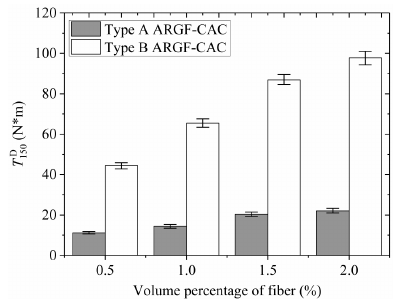
Figure 16. Variation of D T 150 with fiber content.